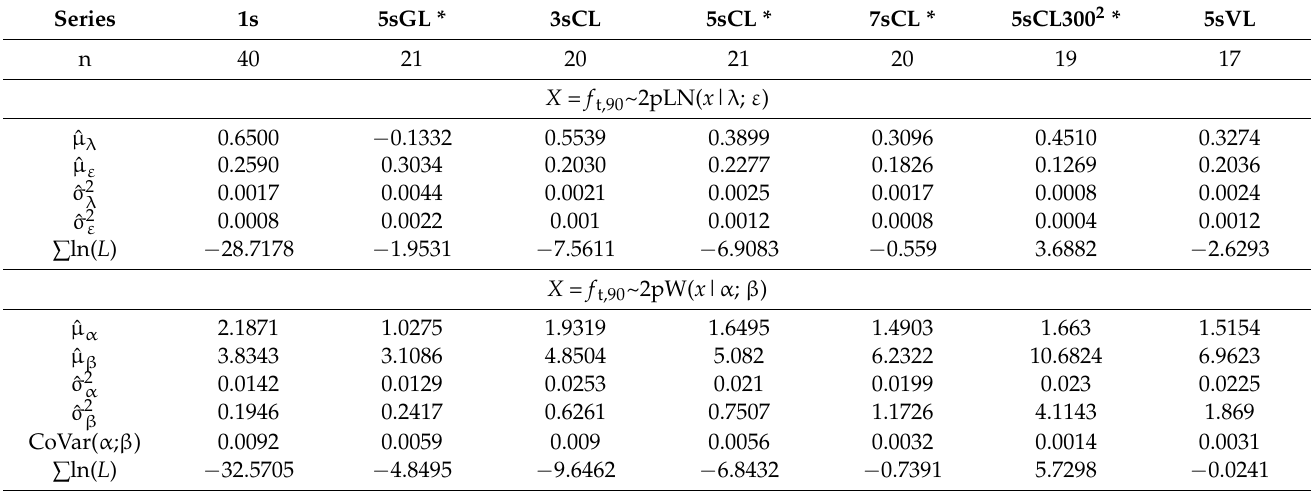
Table 8. Mean values, (co)variances and minimized sums from negative log-likelihood from lognor- mal and Weibull distribution parameter estimations via MLE for tensile strength